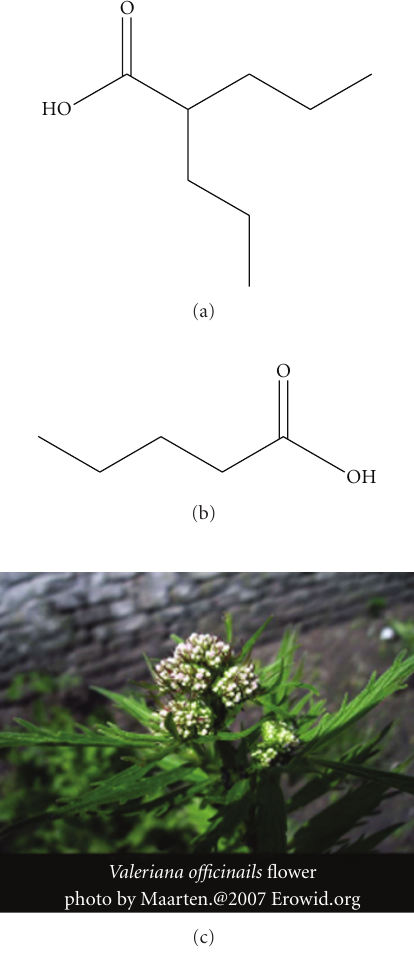
Figure 1: (a) Structure of Valproic acid, (b) structure of valeric acid, (c) valeriana o ffi cinalis (valeriana o ffi cinalis in an early stage of flowering, [Belgium] Photo by Maarten. c (cid:2) 2007 Erowid.org: http://www.erowid.org/herbs/show image.php?i = valerian/valeriana o ffi cinalis flower i2005e1334